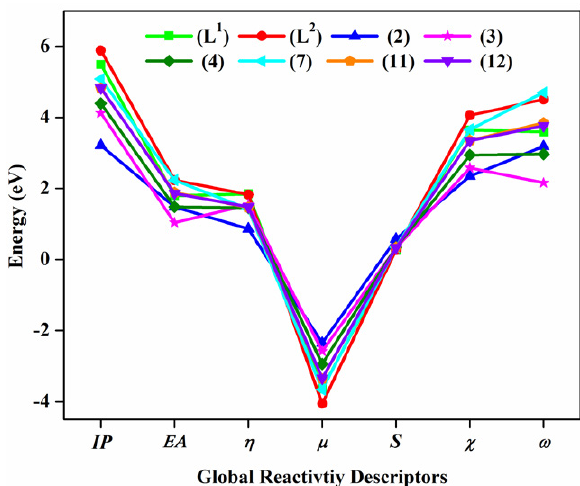
Figure 4. Comparison of global reactivity parameters for ligands vs metal